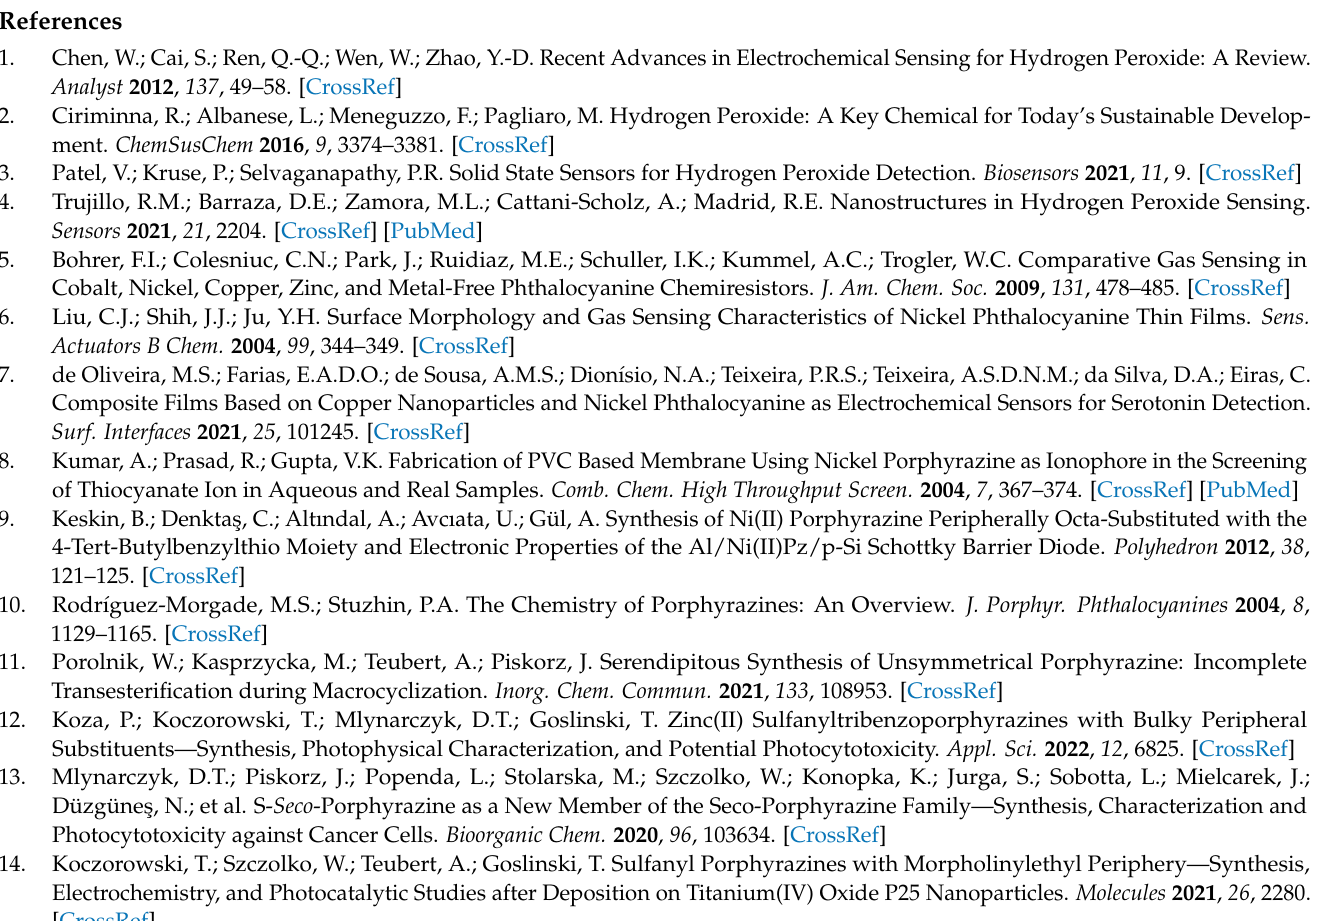
UV–VIS absorption maxima ( λ Abs ) and logarithms of molar absorption coefficients (log ε ) of Pz3 in selected organic solvents. Figure S4: Electrochemical reduction of GC/GO to GC/rGO in phosphate buffer (PB, pH 7.4) in the potential range from 0.4 to − 1.3 V (scanning rate 50 mV s − 1 ). Figure